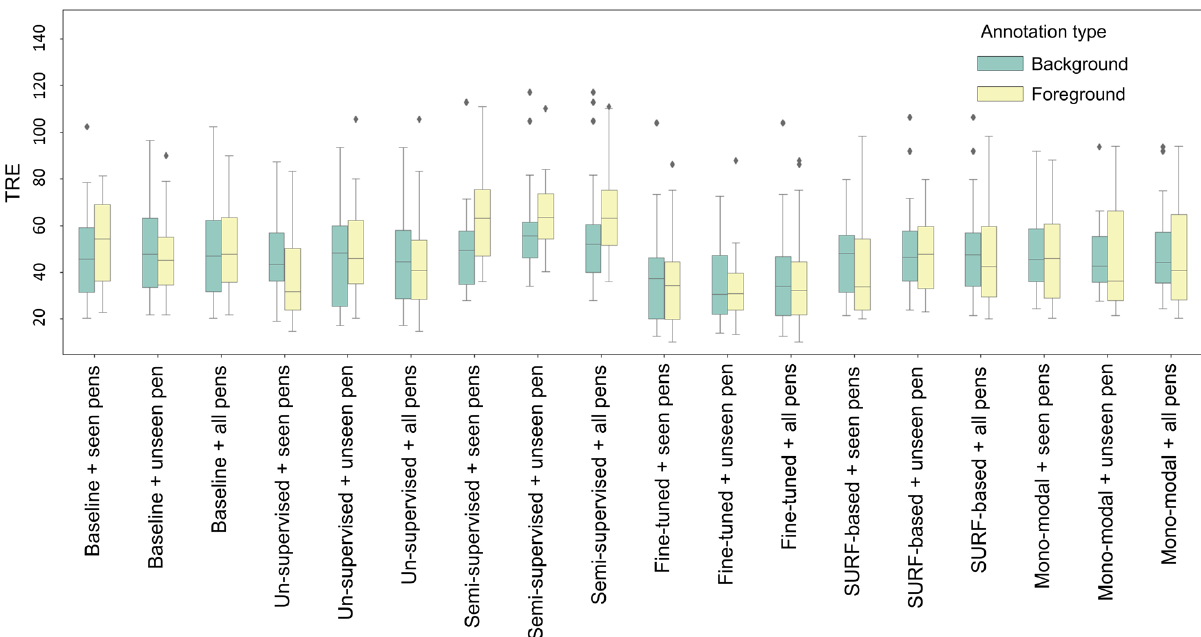
Figure 6. Boxplots of TRE scores of each image registration method for aligning the background and the foreground objects. For each method a cluster of three results are grouped: seen pens, unseen pen, and all